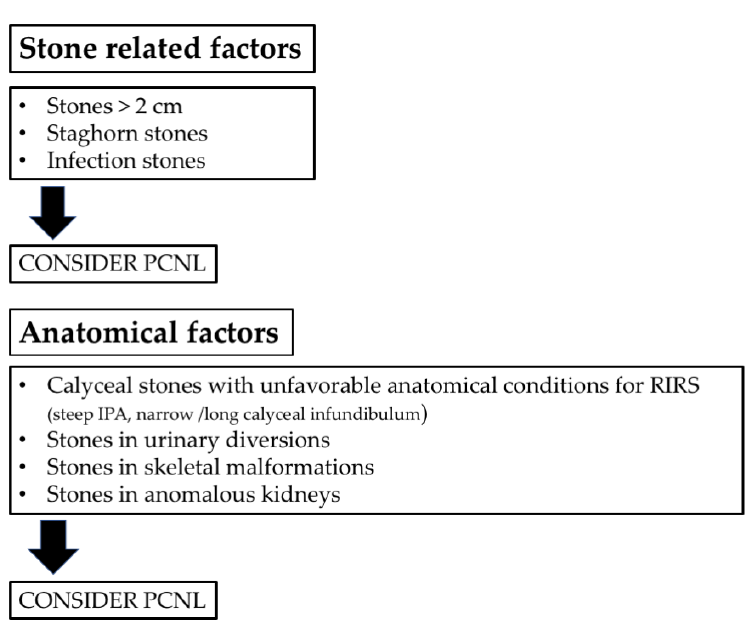
Figure 1. Flowchart for treatment planning (IPA = infundibular-pelvic angle).